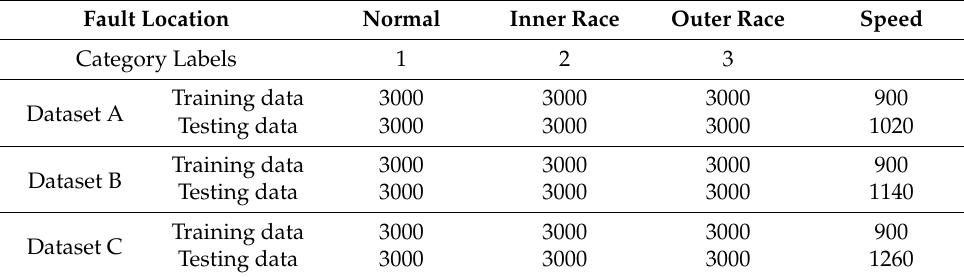
Table 6. The datasets used in the experiment